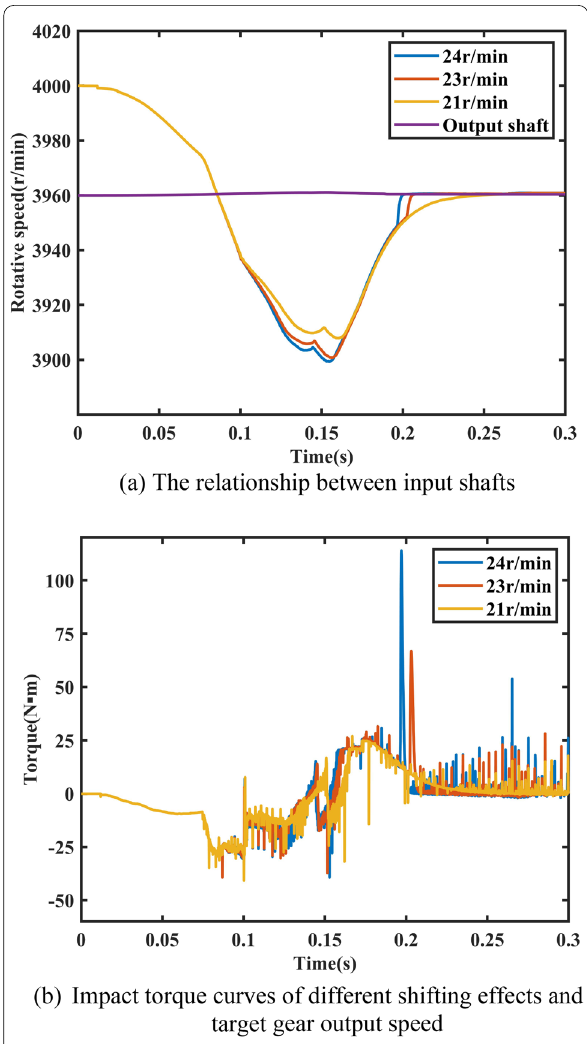
Figure 20 Shifting effect of PCFRS shifting at different moving speeds of the